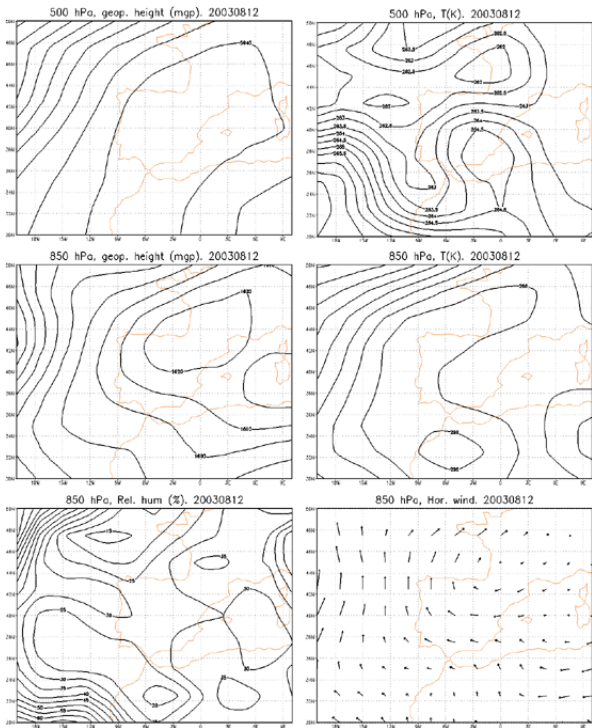
Fig. 10. NCEP reanalysis, 12:00UTC. Date: 12 August 2003, CL4. The atmospheric fields shown are: φ 500 (gpm), T 500 (K), φ 850 (gpm), T 850 (K), rh 850 (%) and wind direction at 850hPa, from left to right.